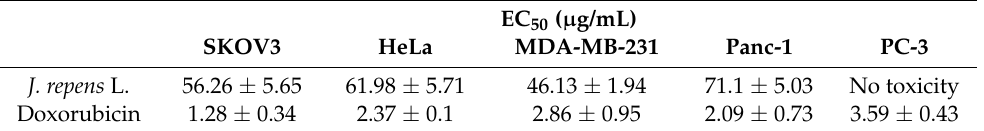
SKOV3: human ovarian cancer cell line, HeLa: human cervical cancer cell line, MDA: MB-231-human breast cell line, PANC-1: human pancreatic cancer cell line, PC3: human prostate cancer cells.